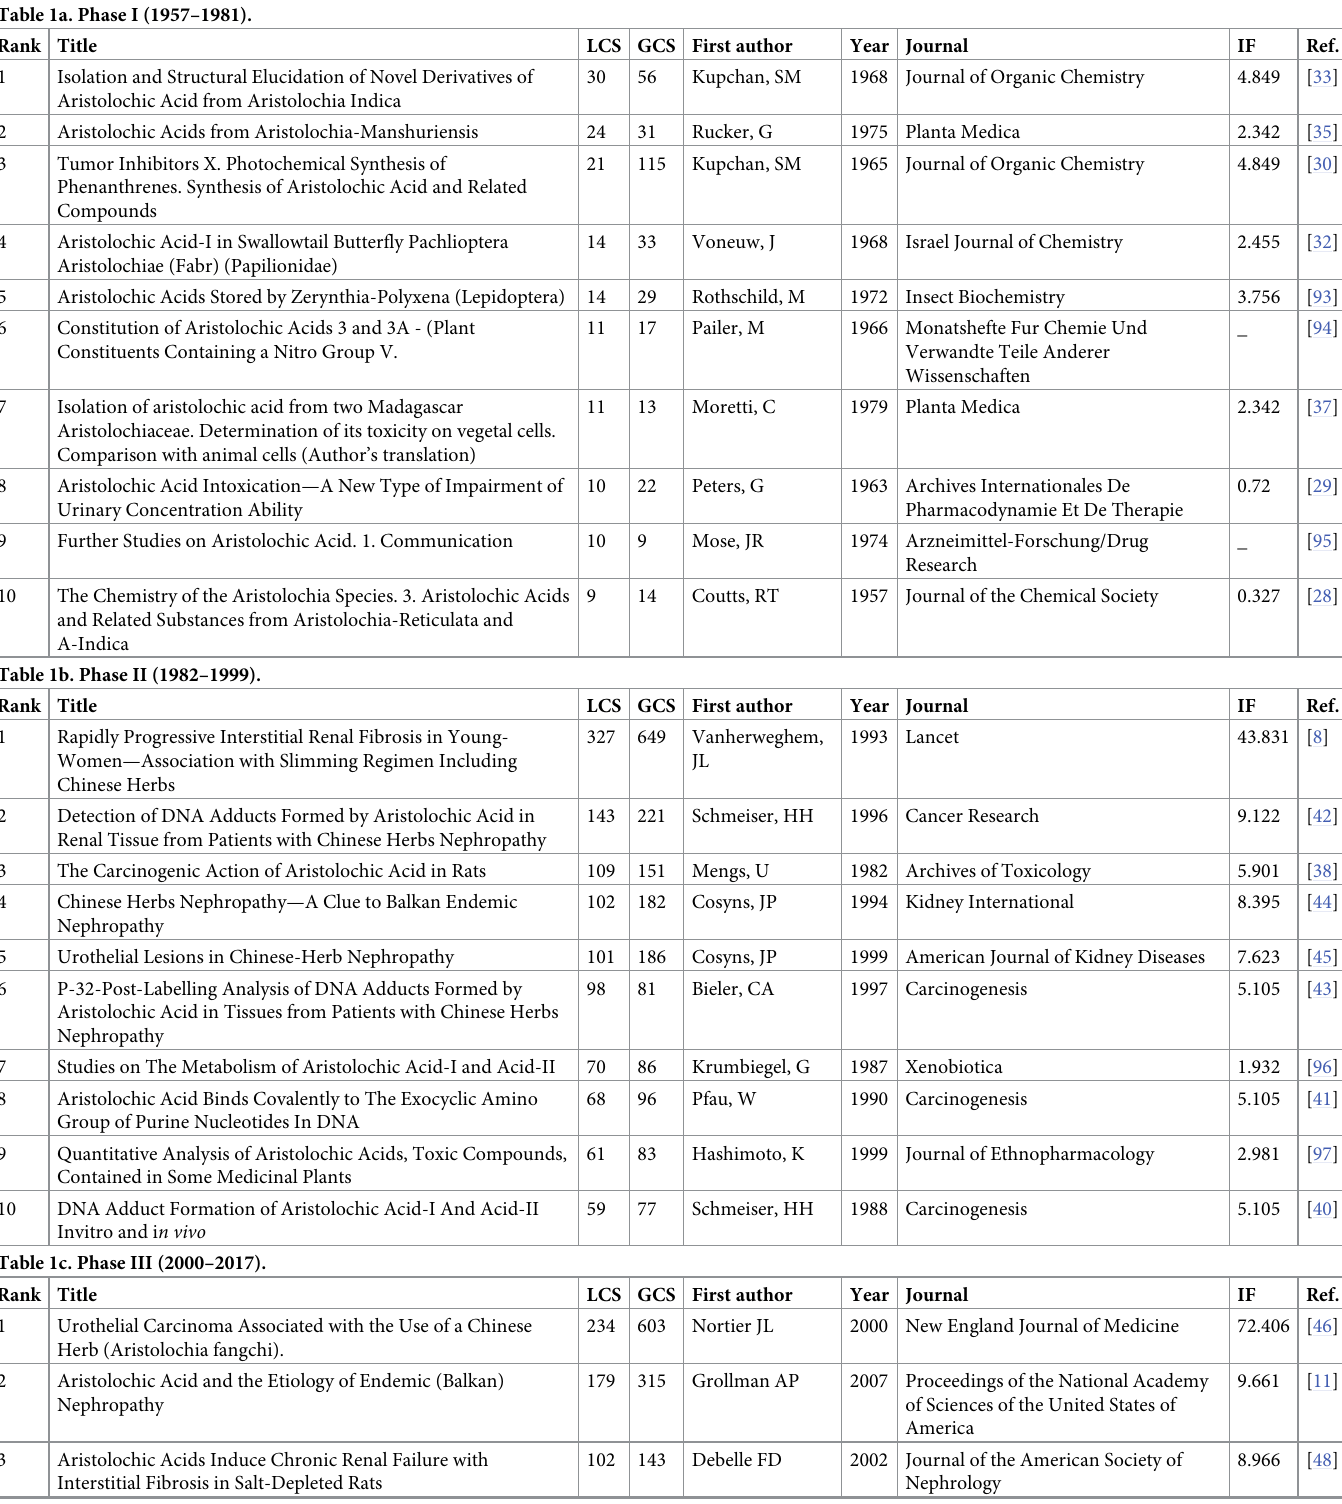
Table 1. Top 10 studies most frequently cited in each phase (1957–2017). Table 1a. Phase I